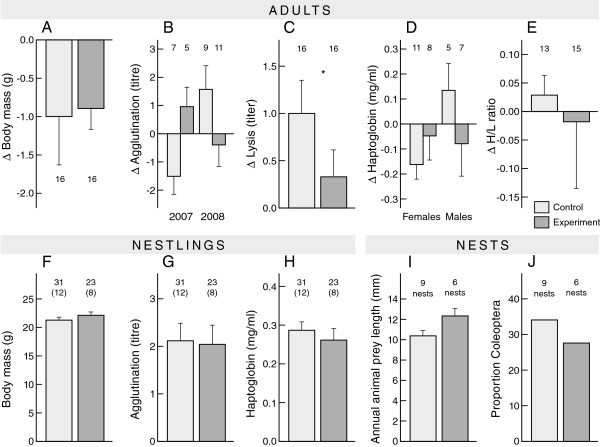
Medium-term (within-season) effects of an experimental handicap on the trade-off between reproduction and self-maintenance in skylarks. A) – E) Adult body mass and immune parameters ca. 5 weeks days after experimental initiation. Values are expressed as the difference between second and first broods. F) – H) Nestling body mass and immune measures in the offspring from control and experimental parents; the latter were assigned to treatment during first broods. I) Average length of animal prey in droppings of nestling skylarks. J) Proportion of the main prey type (beetles, order Coleoptera) in the diet of nestlings. Bars depict mean and standard error. Numbers represent sample size of individual birds. For nestlings the number of nests is given in parentheses. Stars denote statistically significant differences. If both years or sexes are plotted, then the interaction with treatment was significant. Statistical analyses can be found in Results and Additional file 1: Table S2.